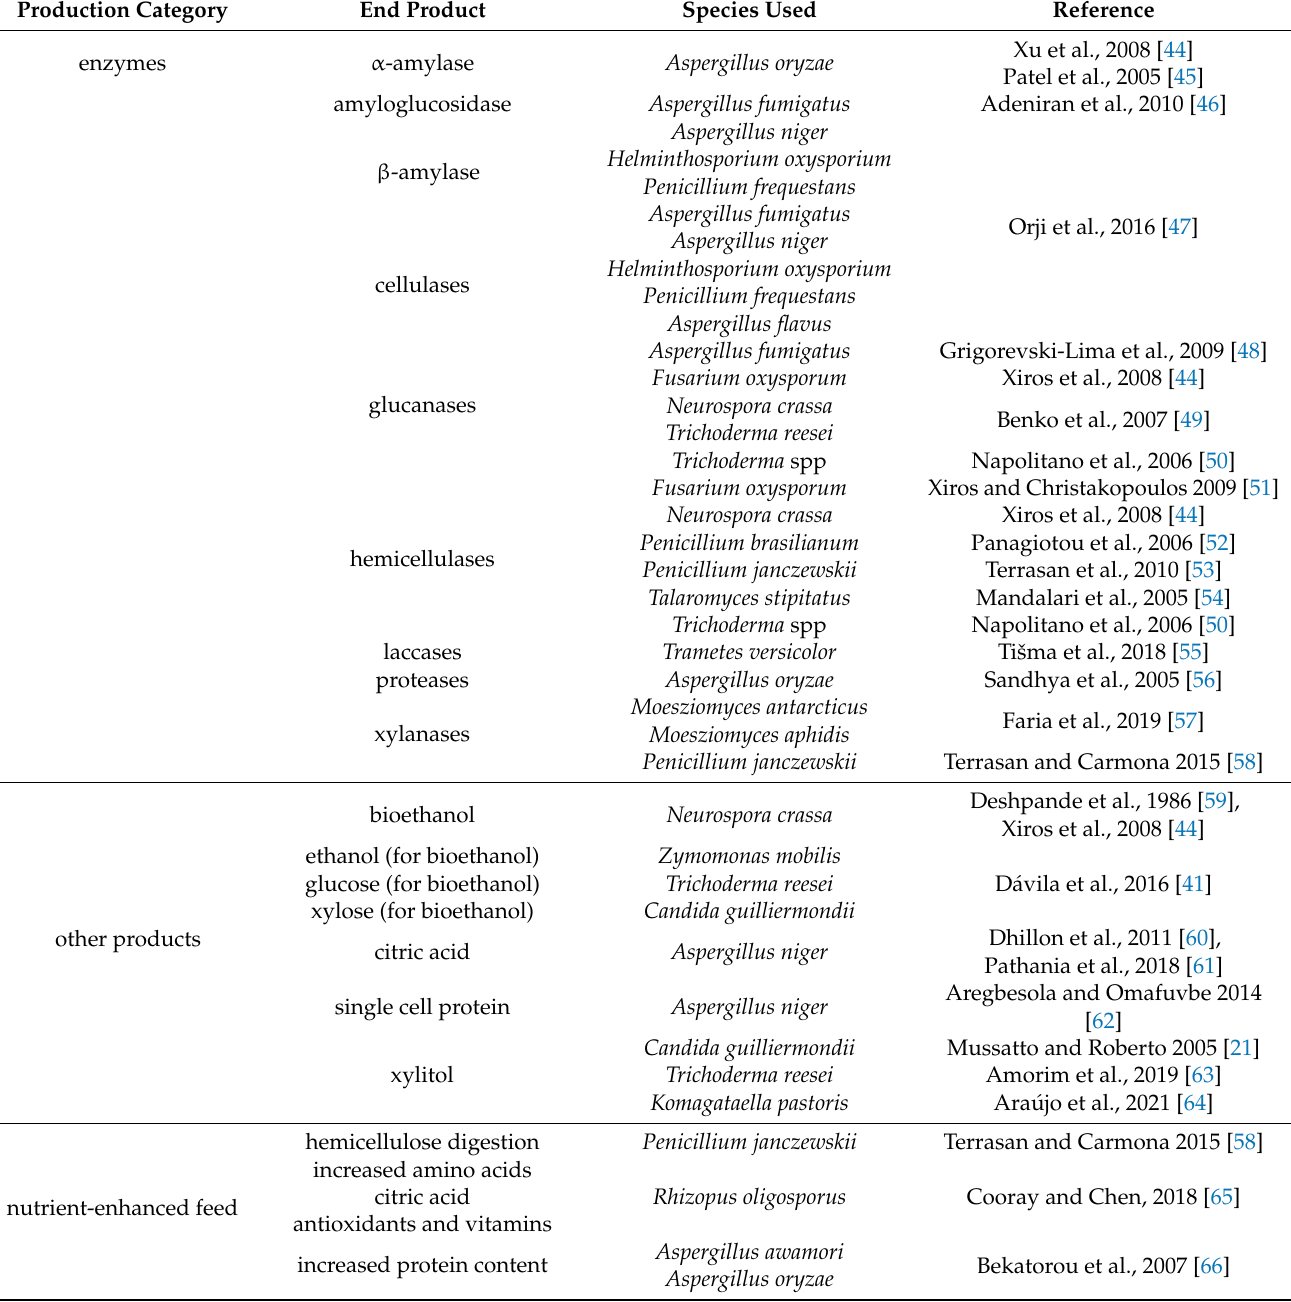
Table 3. Fungal species and the end products of fermentation of BSG, as separated into different production categories. Production